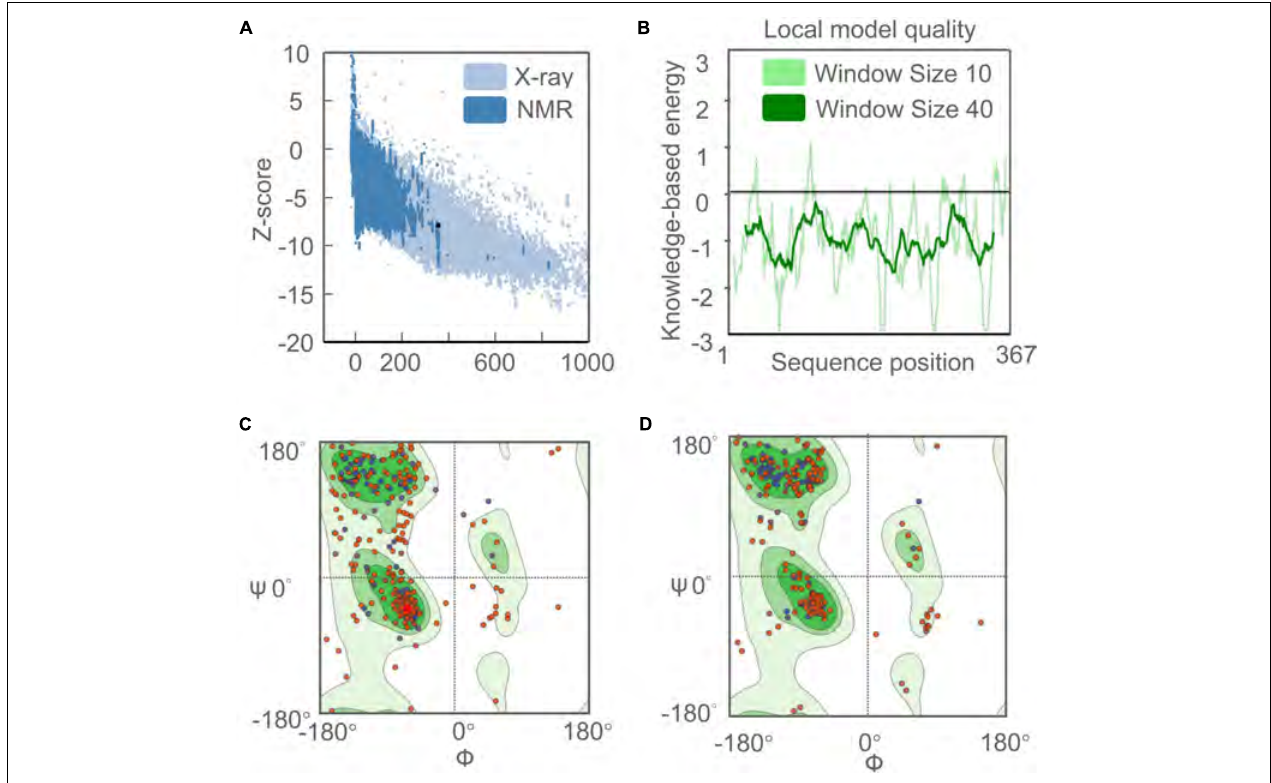
FIGURE 4 | Evaluation and validation of the tertiary structure model of the C543P candidate. (A) Z-score predicted by ProSA-web server: − 7.9. (B) Energy map of C543P peptide molecule validation. (C) Ramachandran diagram analysis of C543P peptide molecule before optimization shows Favored region: 75.39%, outliers region: 7.85%, rotamer region: 9.70%. (D) Ramachandran diagram of C543P peptide molecule optimization: Favored region: 88.77%, outliers region: 1.92%, rotamer region: